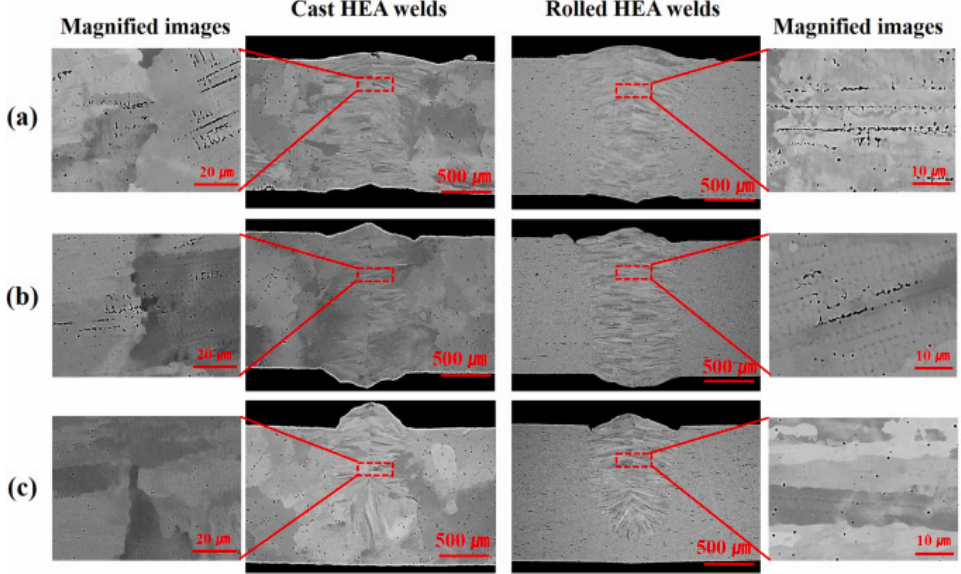
Figure 6. Macrogrpahs of the weld beads for various welding velocities: ( a ) 6 m/min, ( b ) 8 m/min, and ( c ) 10 m/min. Reproduced with permission from [71]. Copyright Elsevier, 2019.